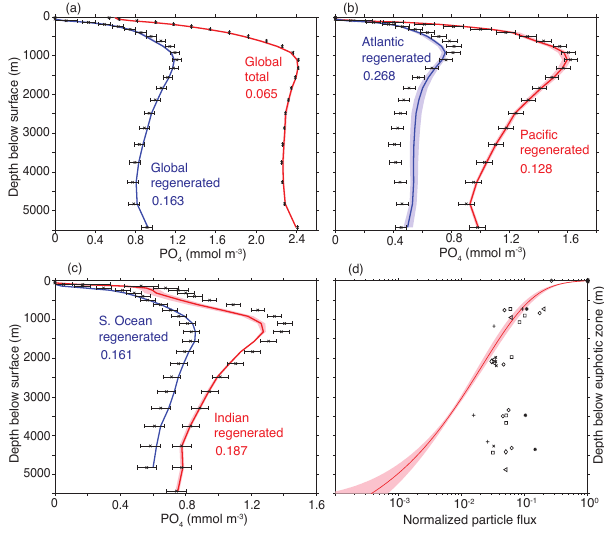
Figure 6. As Fig. 5, but for the BUR